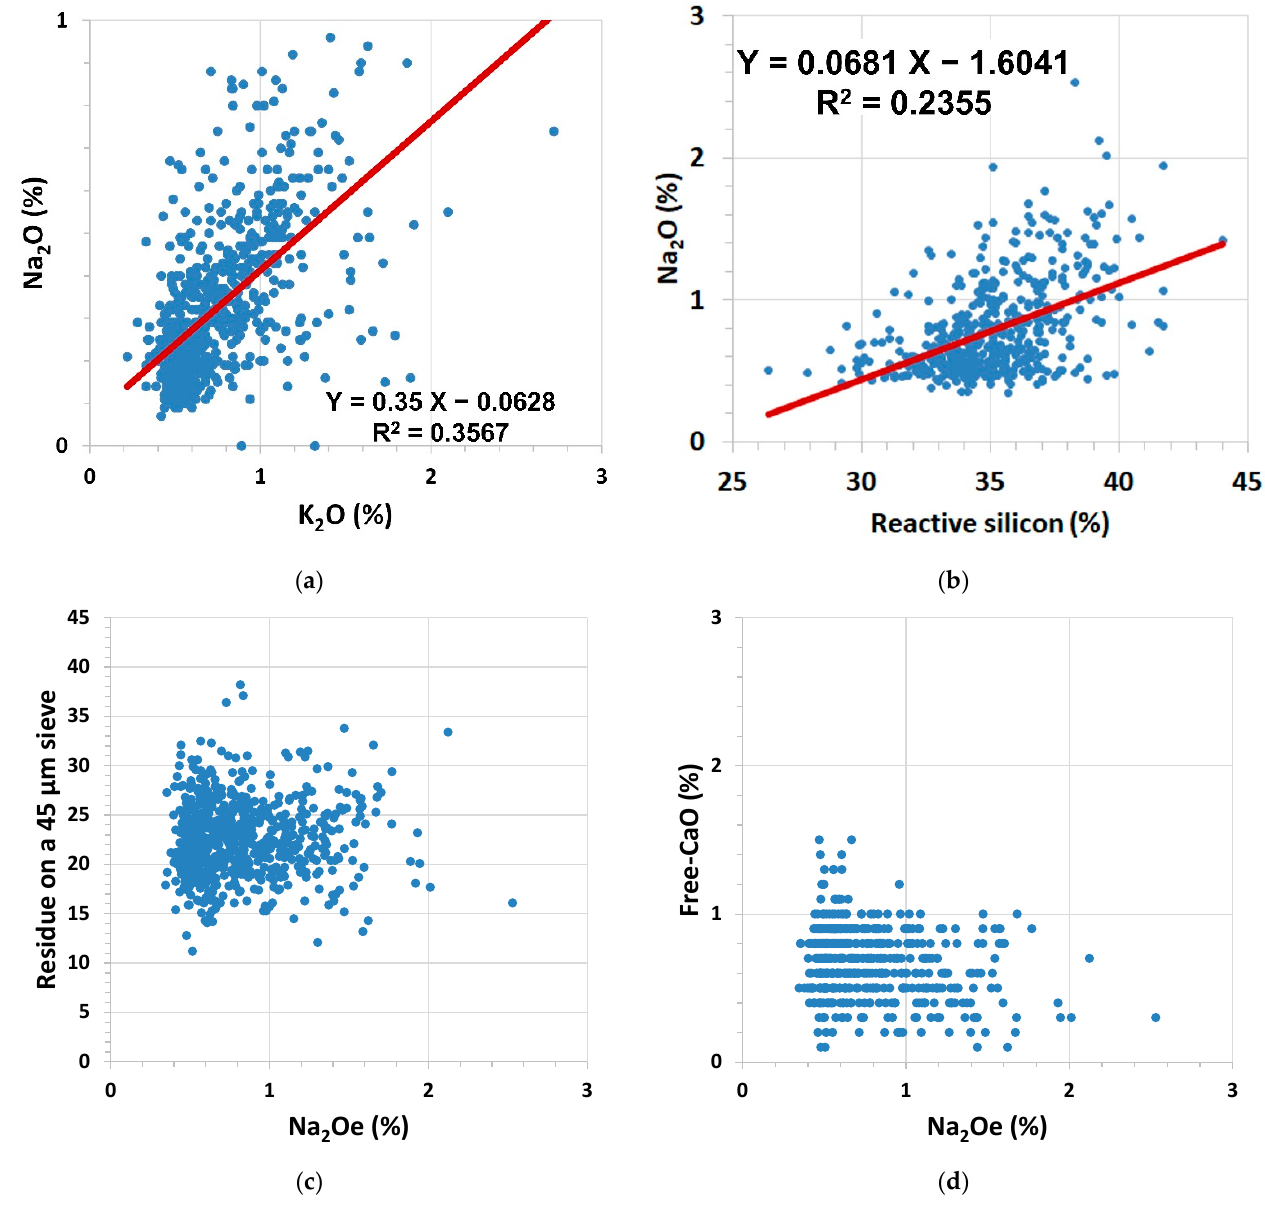
Figure 3. Relationship between the Na 2 O-equivalent and: ( a ) K 2 O; ( b ) reactive silicon; ( c ) 45 µm residue; ( d ) Free lime.